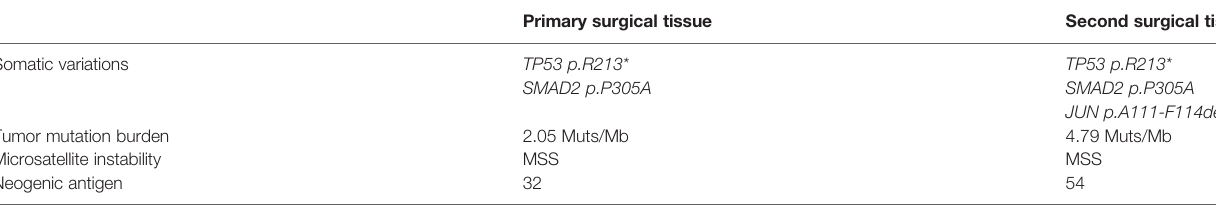
TABLE 1 | The results of WES.